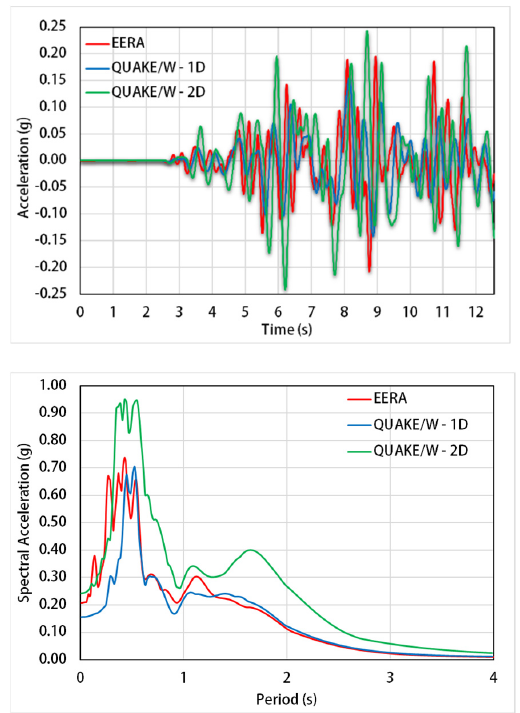
Figure 17. Comparison between 1-D and 2-D analyses performed by EERA and QUAKE/W for point 1 in terms of acceleration time history and spectral acceleration, for the Amoruso et al. [26] input.